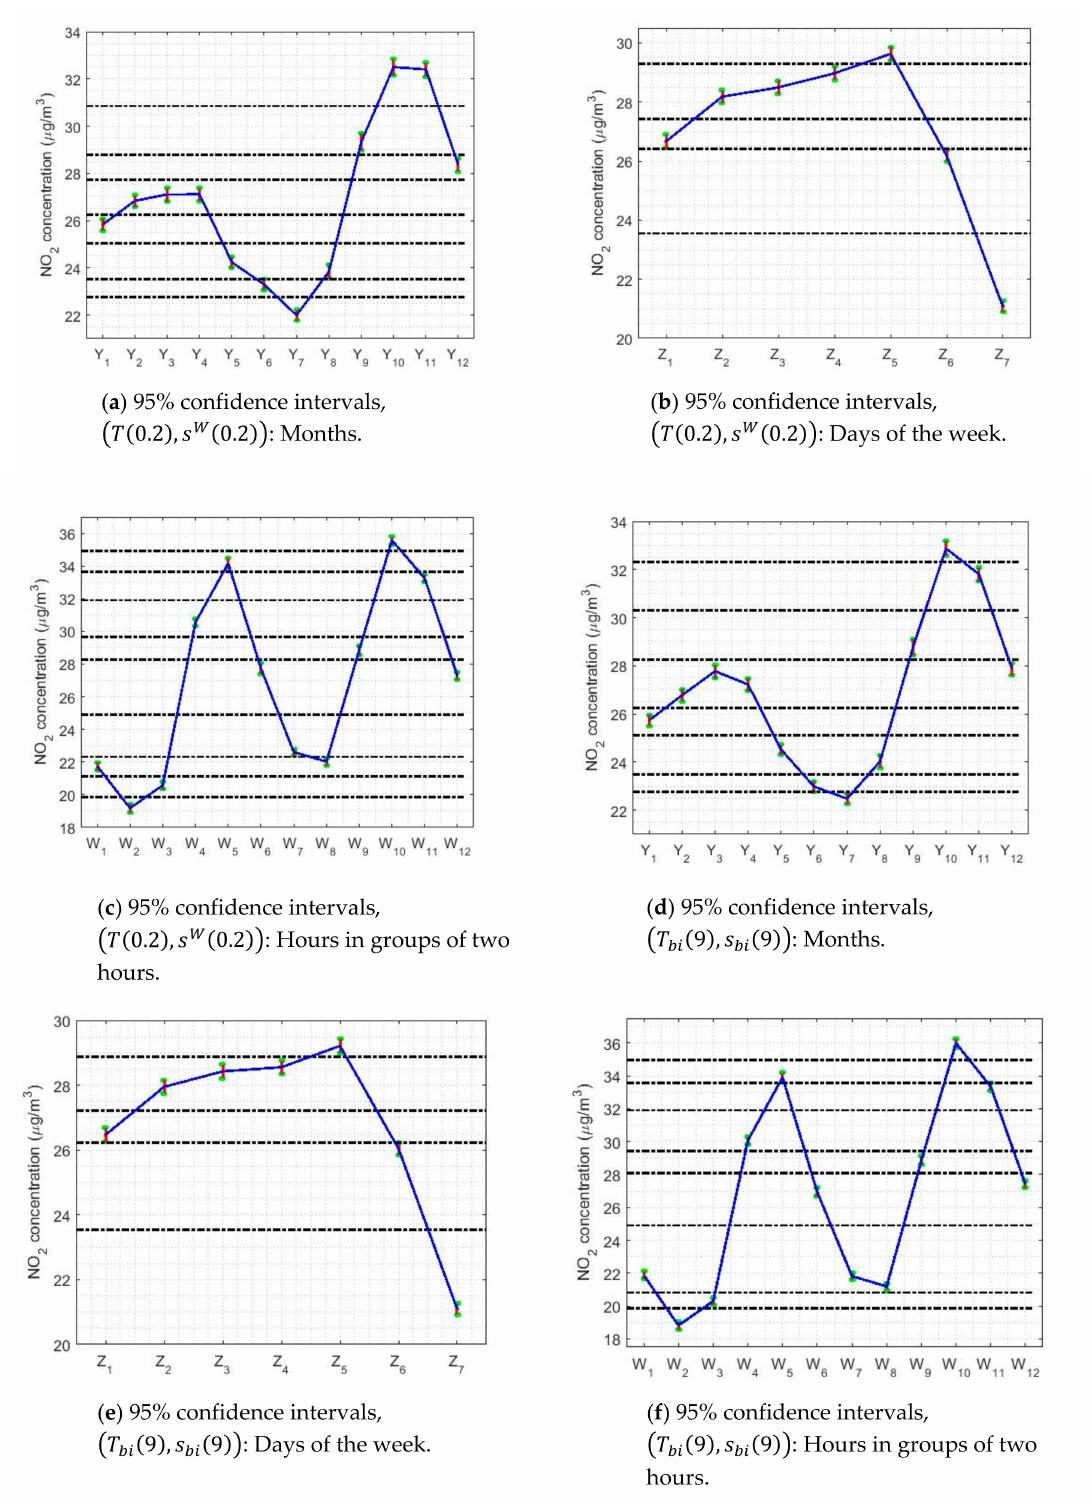
Figure 21. 95% confidence intervals, ( T (0.2), s W (0.2)) and ( T bi (9), s bi (9)), by month ( Y 1 = January, ... , Y = December), day of the week ( Z 12 ( W 1 = 0:00–1:00, ... , W 12 =